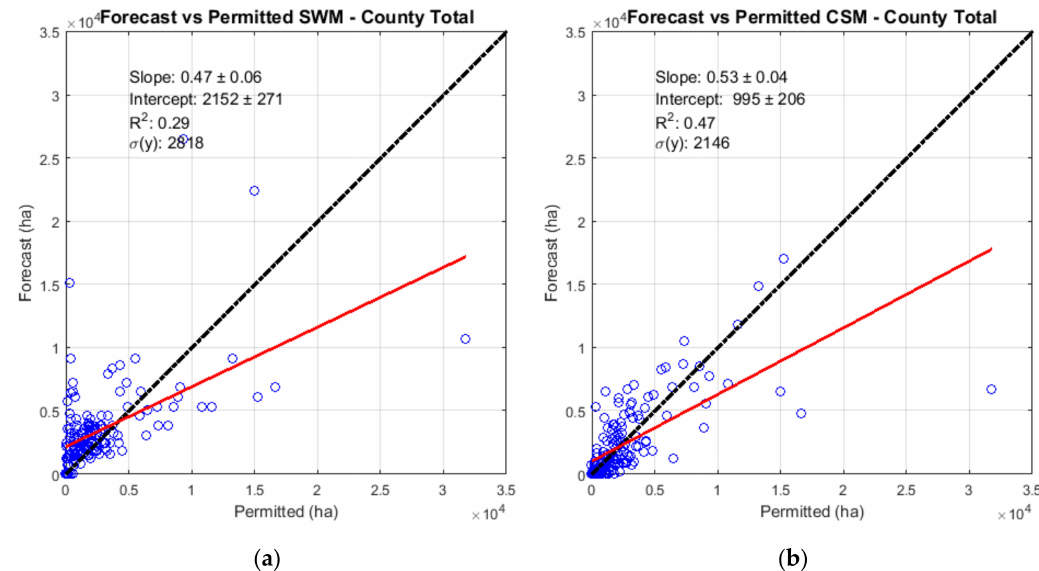
Figure 5. Forecast versus permitted county total burn areas (in ha) in Georgia for the January–April 2015 period: ( a ) statewide model; and ( b ) county-specific